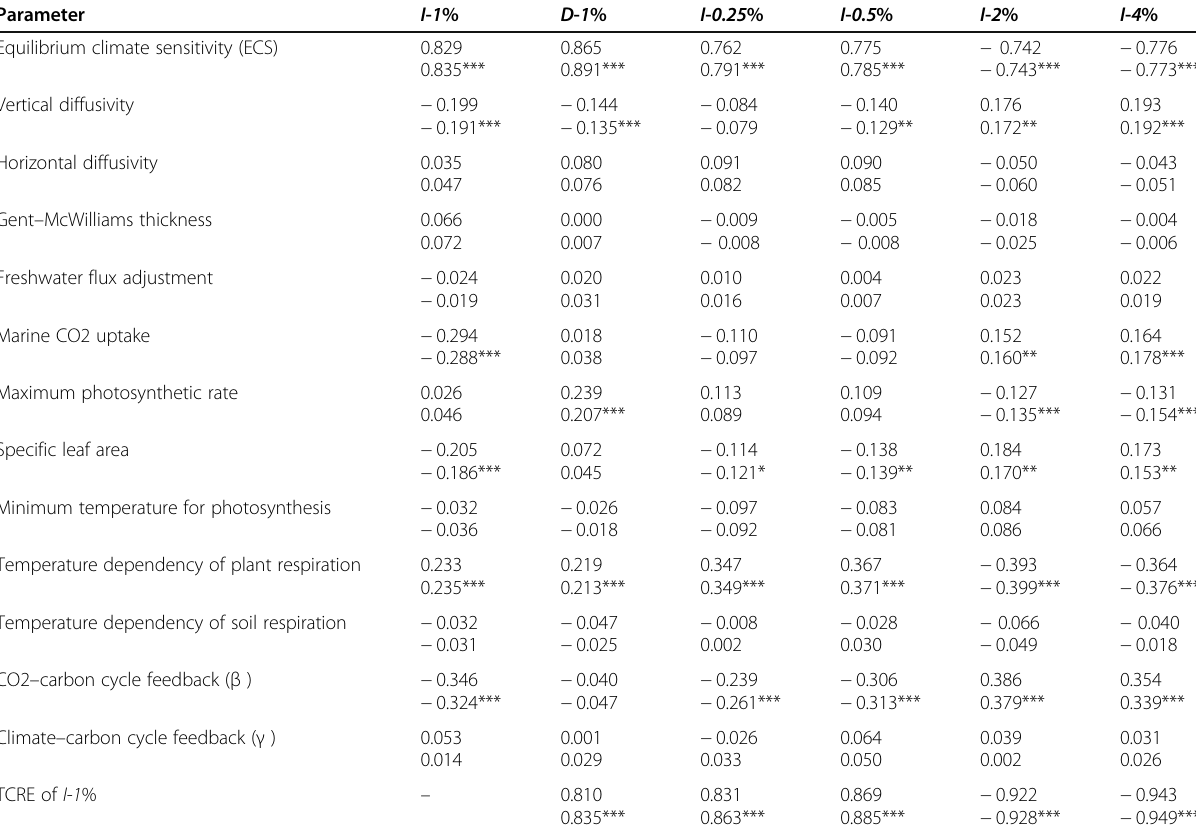
Table 3 Correlation between each parameter, and TCRE in the I - 1 % scenario and the relative TCRE change from the I - 1 %